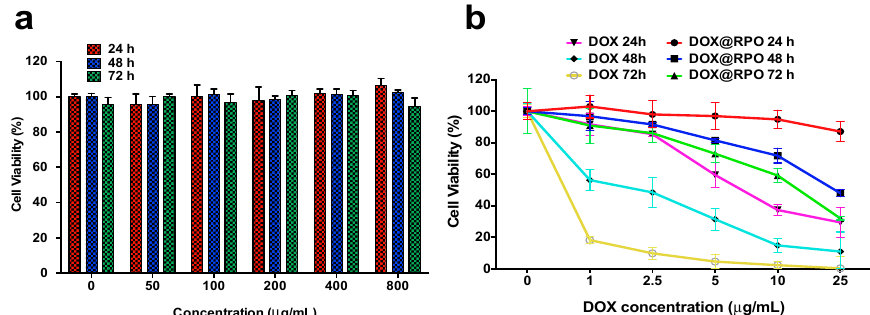
Figure 5. ( a ) Cytotoxicity of HeLa cells tested by PrestoBlue assay after treatments with various concentrations of RPO-3 micelles for 24, 48, and 72 h, respectively. ( b ) Cell viability of HeLa cells tested by PrestoBlue assay after treatments with various DOX concentrations of DOX@RPO-3 NPs and free DOX for 24, 48, and 72 h, respectively. Data were shown as means ± SD ( n = 5).